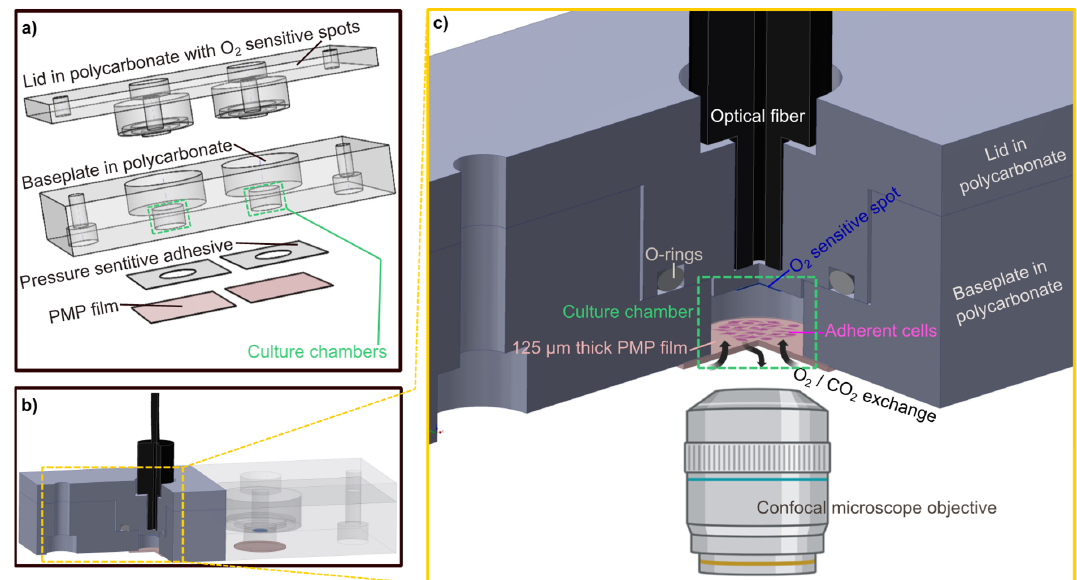
Figure 1. The developed culture chamber device. Culture chamber device designed to allow assessment of the PMP material. ( a ) An exploded ‐ view drawing of the individual parts of the culture chamber device: the lid milled in polycarbonate with O 2 sensitive spots attached, the baseplate milled in polycarbonate where the dimensions of the culture chambers are defined (green), a pressure sensitive adhesive (PSA) layer and the gas permeable PMP film. ( b ) The assembled culture chamber device with the optical fiber inserted into the customized cavity. For better visualization, the polycarbonate parts are made transparent in the right half of the device while they are filled with solid colors in the left half where a cross ‐ sectional view exposes the culture chamber. O 2 ‐ sensitive spots (blue) and PMP film (pink) are illustrated. ( c ) An enlarged schematic of the section marked yellow in ( b ). The cross ‐ sectional view of the device exposing the culture chamber and its components. The 3D device images were created with Inventor 2022, illustrations of microscope objective and adherent cells were created with BioRender.com (accessed on 21 November 2022) .